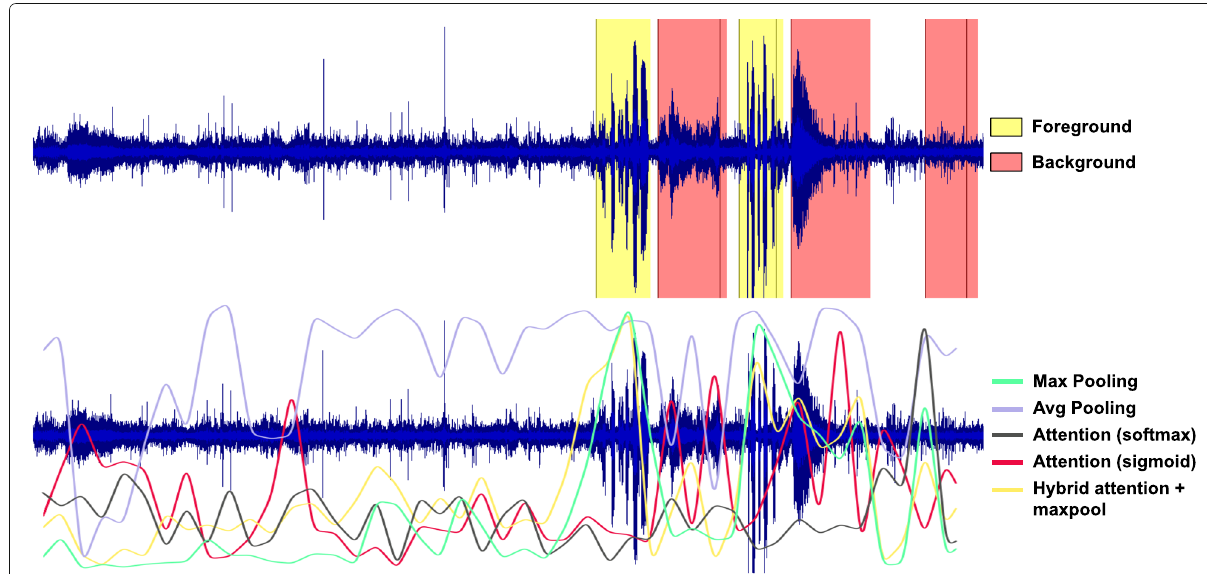
Fig. 3 Visualization of different pooling methods for foreground localization using gentle-aligned regions as labels; top : ground-truth regions of foreground and background speech; bottom : foreground posteriors of different models